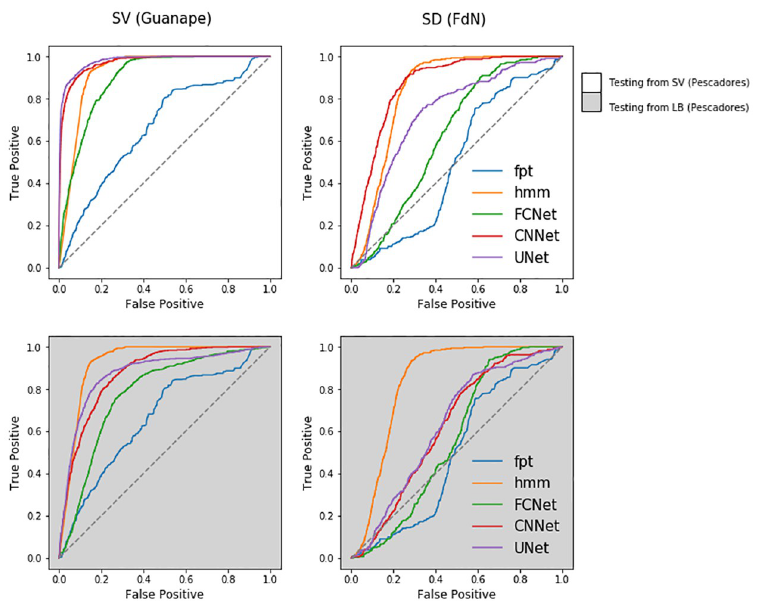
Fig 5. Performance of tested deep networks. ROC curves obtained from the prediction of 5 algorithms, First-Time Passage (FPT), Hidden Markov Models (HMM), Fully-Connected Network (FCNet), Fully-Convolutional Network (CNNet) and U-Network (UNet) on 2 distinct test datasets. SV stands for Peruvian boobies ( Sula variegata ), and LB stands for Guanay cormorants ( Leucocarbo bougainvilli ). The deep networks used in this figure have been trained on the dataset from Pescadores (see Fig 3 and Table 2). They have been used for dive prediction of Peruvian boobies in Gua ñ ape (left column) and for masked boobies in Fernando de Noronha (right column).